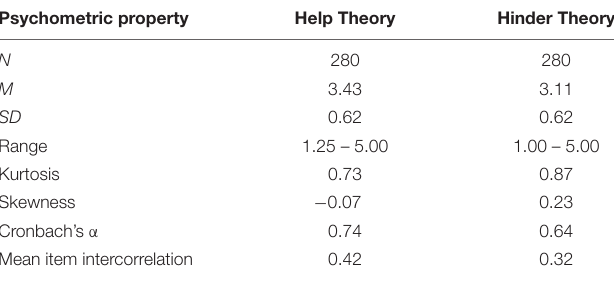
TABLE 1 | Descriptive data for the Help and Hinder Theories about Emotion Measure in Study